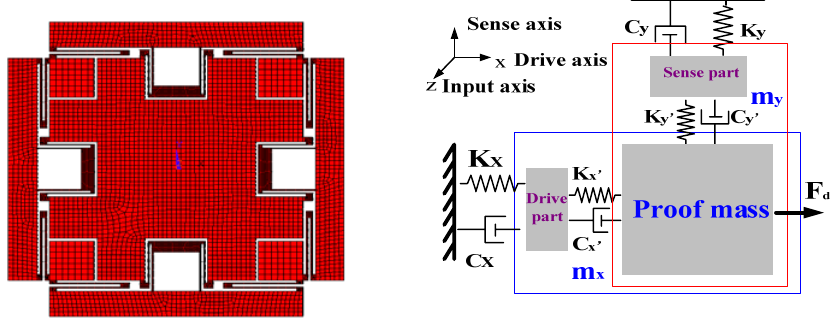
Figure 1. The structure and model of